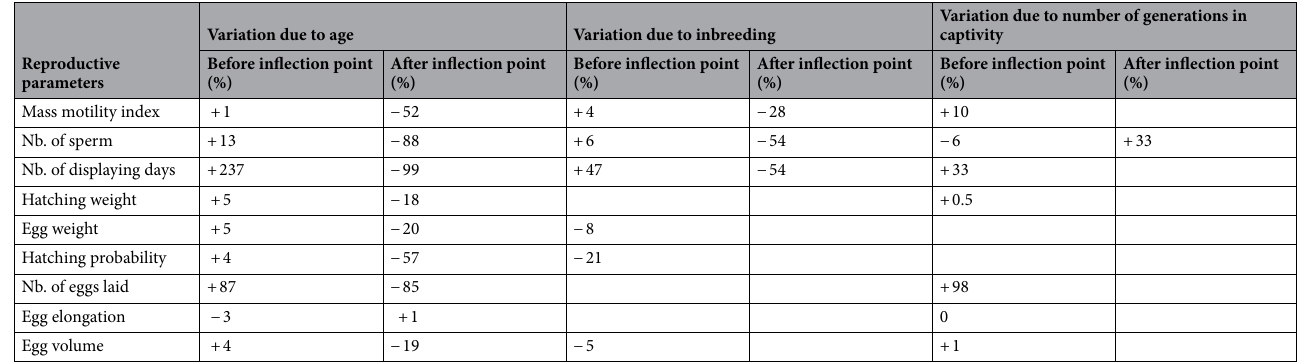
Table 4. Comparison of effect sizes through percentages of variation between the predicted value when the explanatory variable is at minimum (at age = 1; at F = 0; or at G = 0) and the predicted value when the explanatory variable is at maximum (at age = 32 for males and 25, 26, or 28 for females; at F = 0.25; or at G = 4.8 for males and 5.1 for females). Two percentages are indicated when a quadratic relationship was included in the model. Percentage of variation was only computed when effect of a variable was significant ( p value < 0.05).